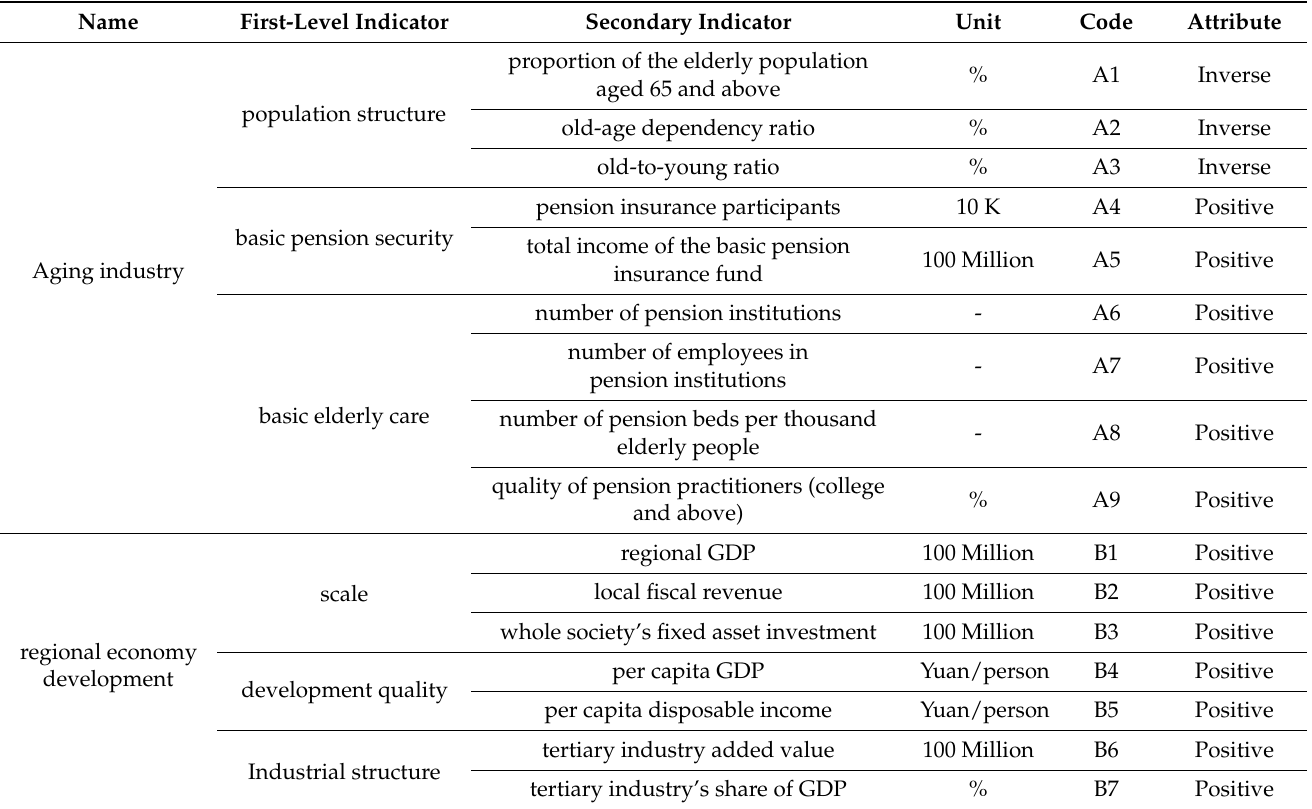
Table 1. Evaluation index system of the aging industry and regional economy